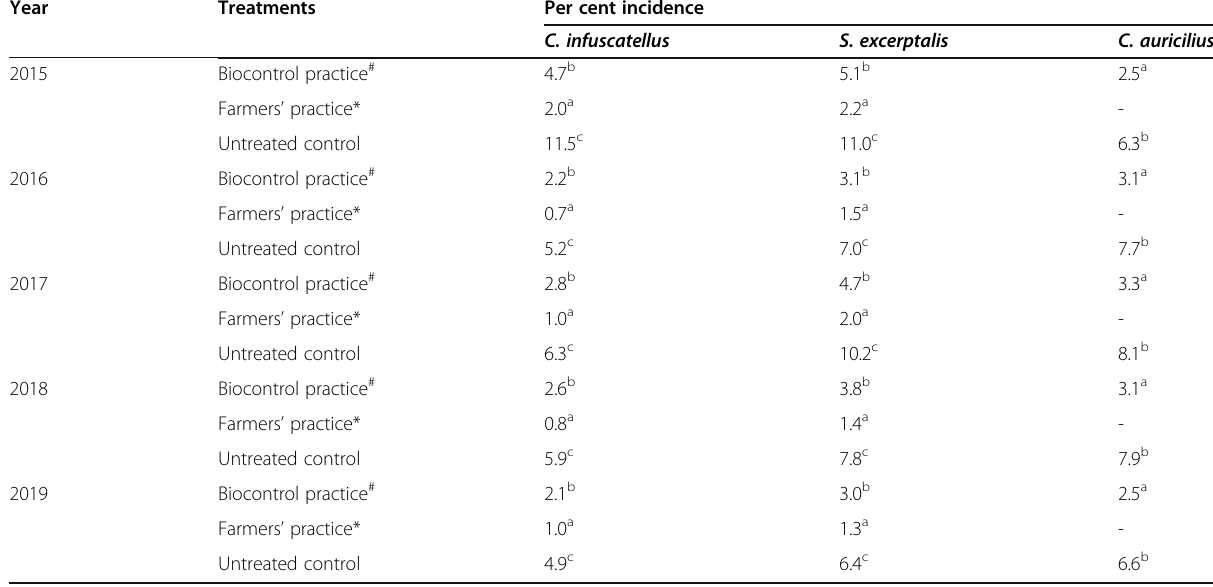
Table 2 Effect of different management practices on the incidence of sugarcane